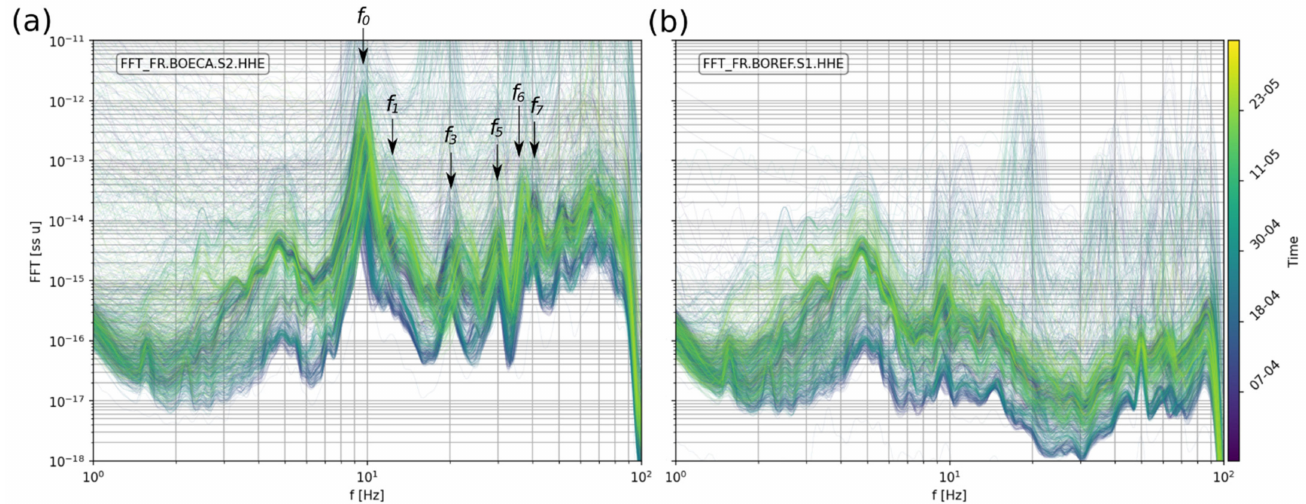
Figure 2. Multitaper FFTs of 1 h segments for unstable column’s BOECA ( a ) and stable massif BOREF ( b ) sensors. The color scales with time during the monitoring period (from dark blue to yellow, see color bar). Column’s natural frequencies from the detailed study by [78] are shown with vertical